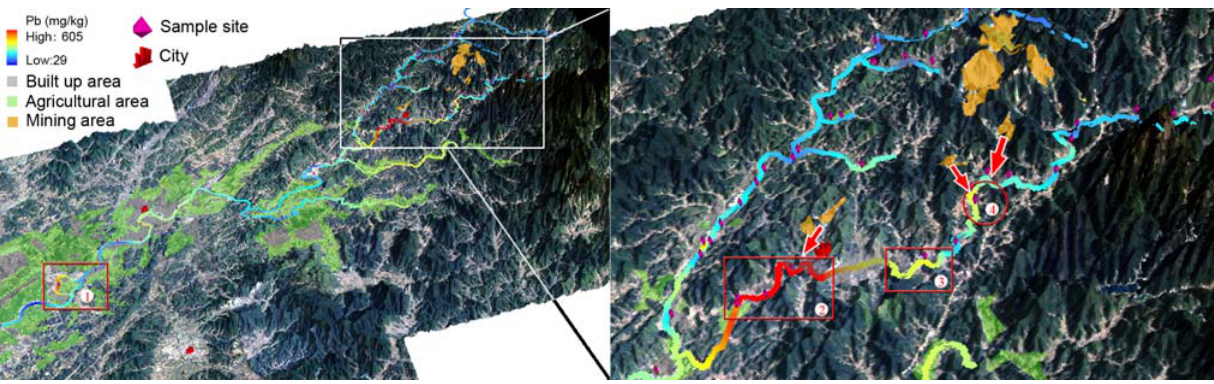
Figure 6. Maps showing the distribution of total Pb content in the soil along the Le’an River and its branches (left), and in the soil around mining area